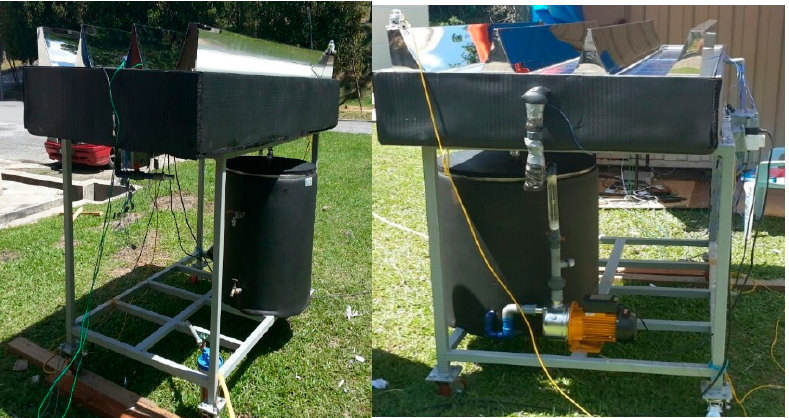
Figure 4. Photograph of the experimental set-up.